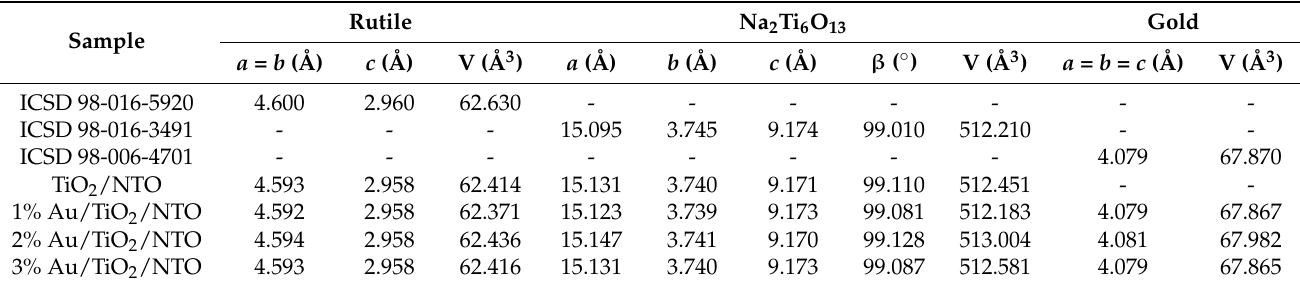
Table 3. Crystal lattice parameters of the